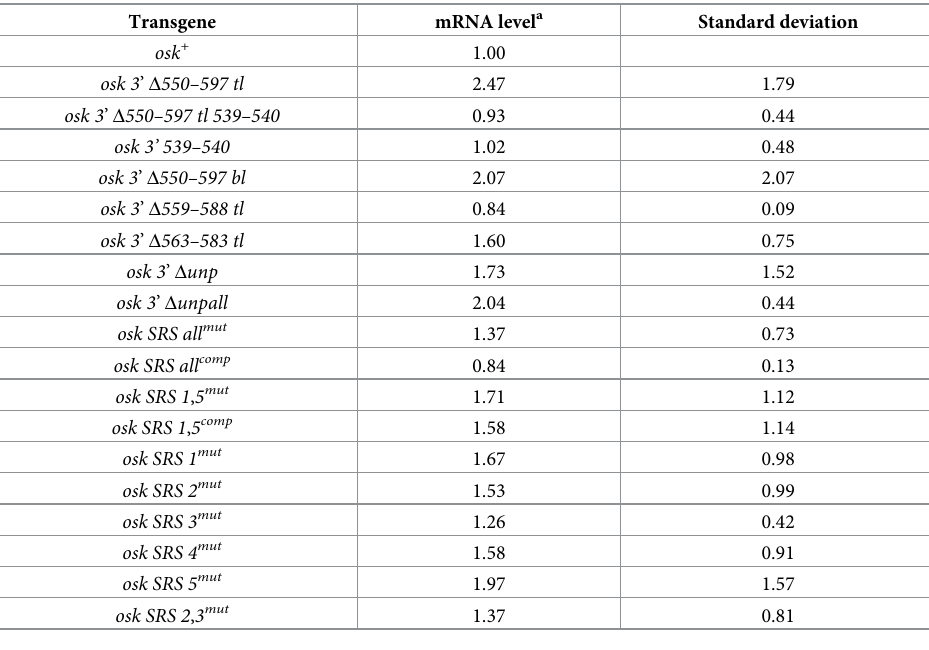
Table 1. Relative levels of genomic osk transgene mRNAs.